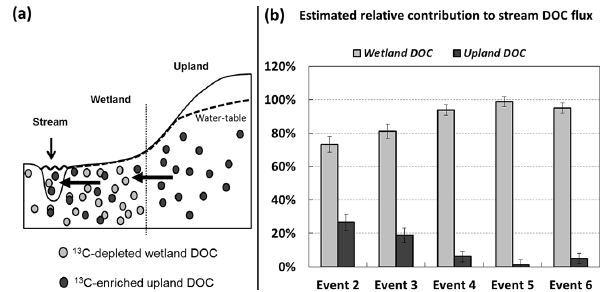
Figure 10. (a) Sketch illustrating the opportunity offered by sta- ble carbon isotopes to quantify the relative contribution of riparian and upland DOC sources and (b) estimated relative contribution of riparian and upland DOC sources to stream DOC